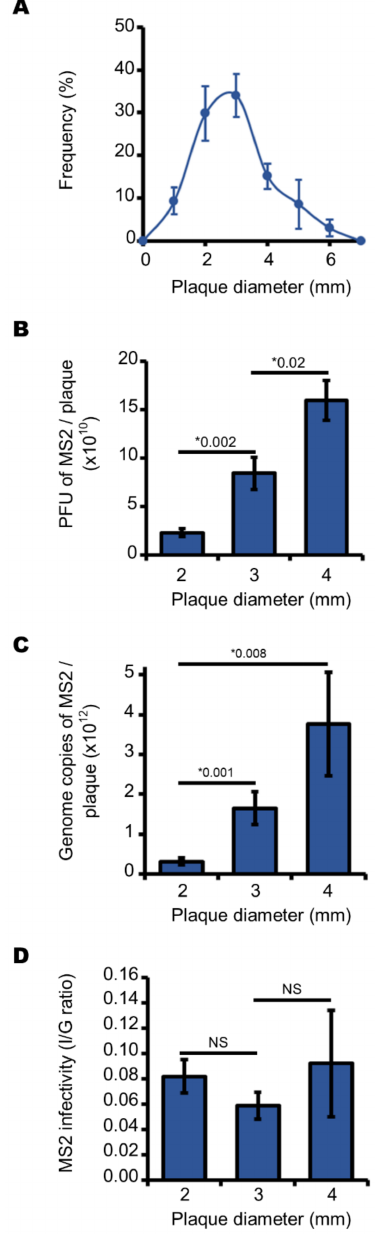
Figure 2. Larger plaques contain more infectious MS2 phages and genomes, but all plaques contain MS2 phages with similar levels of infectivity when cultured under anaerobic conditions. ( A ) curve showing the normal distribution of the plaques’ diameter (in mm) formed by infectious MS2 phages cultured on a lawn of E. coli . ( B ) histogram showing the increasing number of infectious MS2 phages depending on plaque diameter, ranging from 2.0 to 4.0 mm. ( C ) histogram showing the increasing number of MS2 genome copies depending on plaque diameter, ranging from 2.0 to 4.0 mm. ( D ) histogram showing the stable I/G ratio of infectious particles (I) divided by the number of MS2 genome copies (G) depending on plaque diameter, ranging from 2.0 to 4.0 mm. Each data point is an average of several replicates ( n = 7 for panel ( A ); n = 6 for panels ( B – D )) obtained on three separate days. Error bars indicate standard errors. “*” stands for “ p value” determined as described in the Materials and Methods section. “NS” stands for statistically non-significant: p >